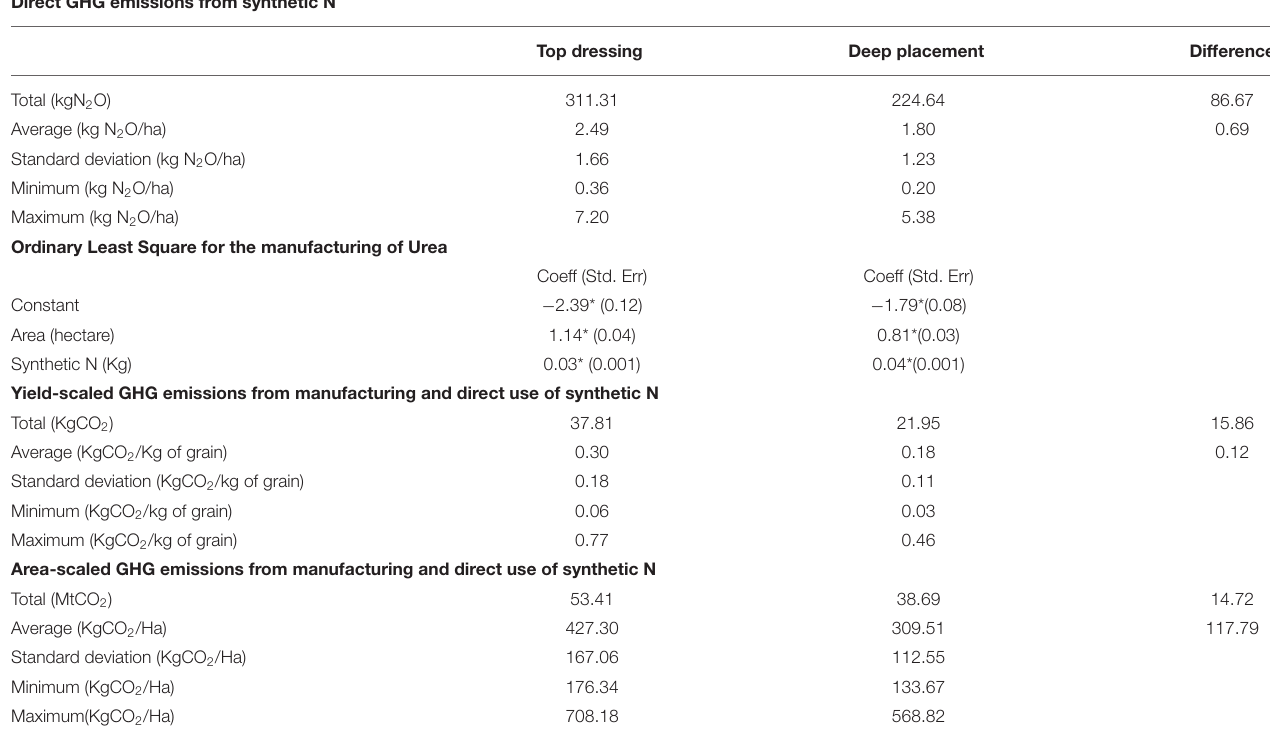
TABLE 11 | Direct, OLS, yield, and area-scaled GHG emissions from synthetic N. Direct GHG emissions from synthetic N Top dressing Deep placement